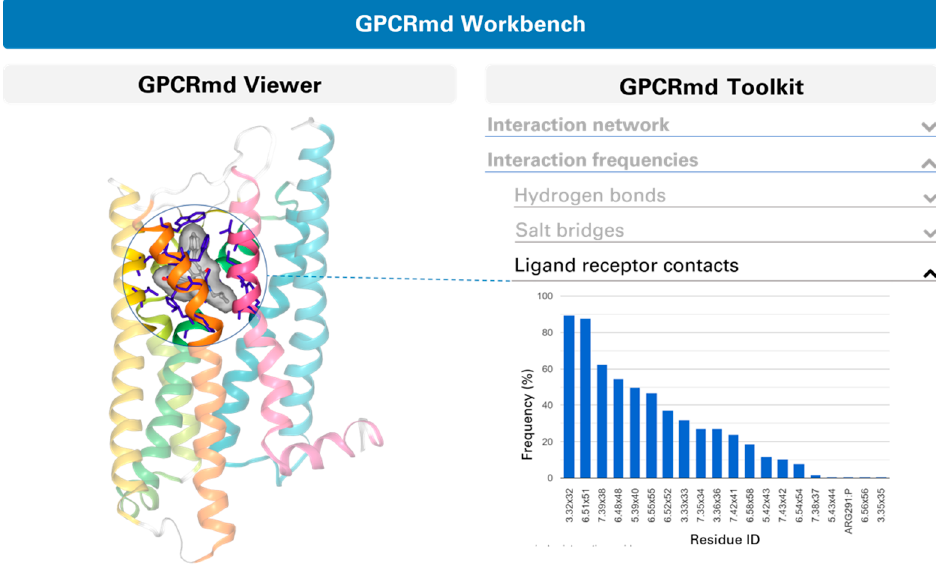
Figure 2. Schematic view of the ligand-protein interaction results that can be obtained with the GPCRmd server [53]. Specifically, the GPCRmd Workbench module of the server enables interactive visualization (GPCRmd Viewer) and analysis (GPCRmd Toolkit) for individual simulations, including ligand-protein interactions among others. Figure obtained from the GPCRmd server [53].